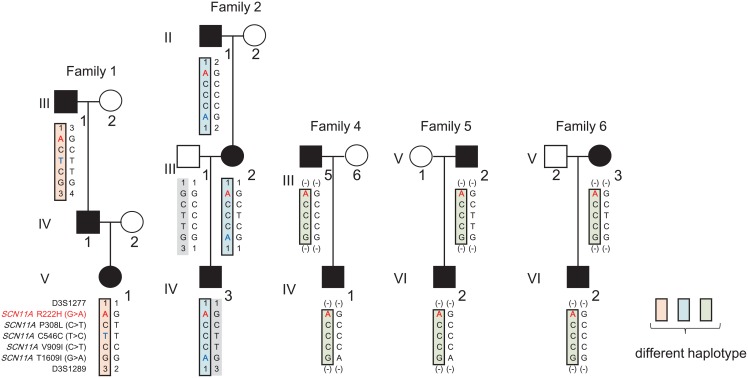
Three different haplotypes carrying R222H in five families.Haplotypes in Family 1, 2, 4, 5, and 6 are shown for five SCN11A variants (R222H, P308L, C546C, V909I, and T1609I) and two microsatellite markers flanking SCN11A (D3S1277 [Position: 34,614,226 bp, NCBI build 38.2] and D3S1289 [Position: 54,445,451 bp, NCBI build 38.2]; determined in Family 1 and 2). Variant genotypes were determined by exome analysis or direct sequencing. Microsatellite marker genotypes were determined using the ABI Prism Linkage Mapping Set. Three different haplotypes carrying R222H are represented in orange, blue, and green boxes. Red characters show the minor R222H allele. Blue characters show genotypes not shared by the other families.